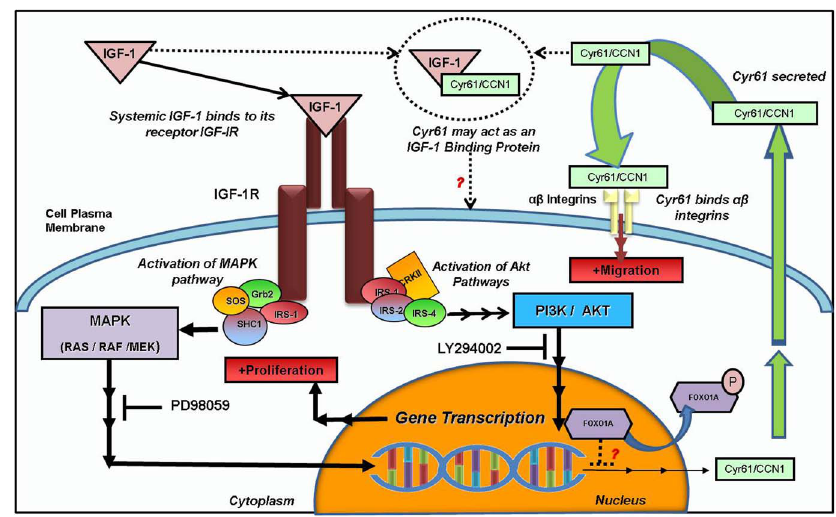
Figure 6. Proposed Schematic of IGF-1 mediated signaling in relation to Cyr61 expression and activity.